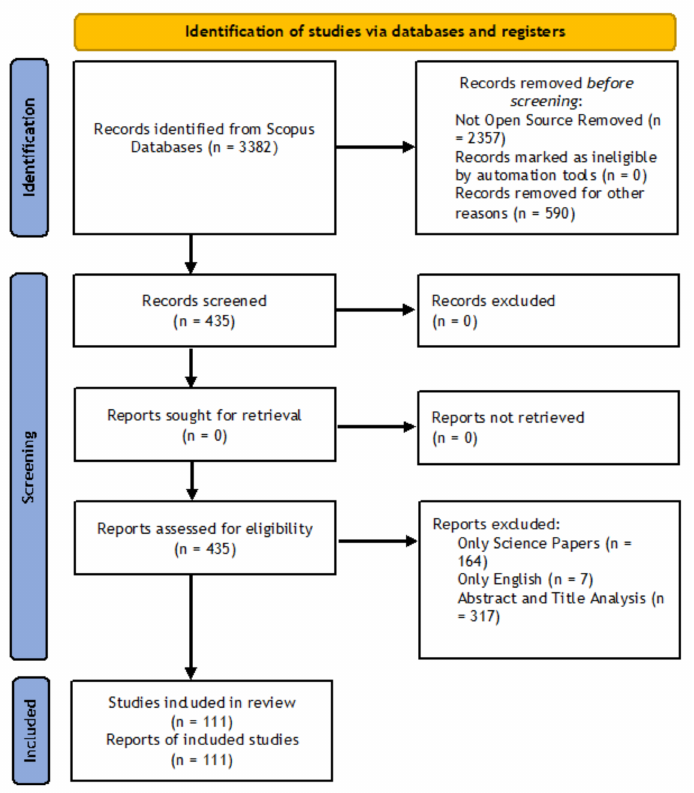
Figure 1. Identification of Studies Via Web of Science